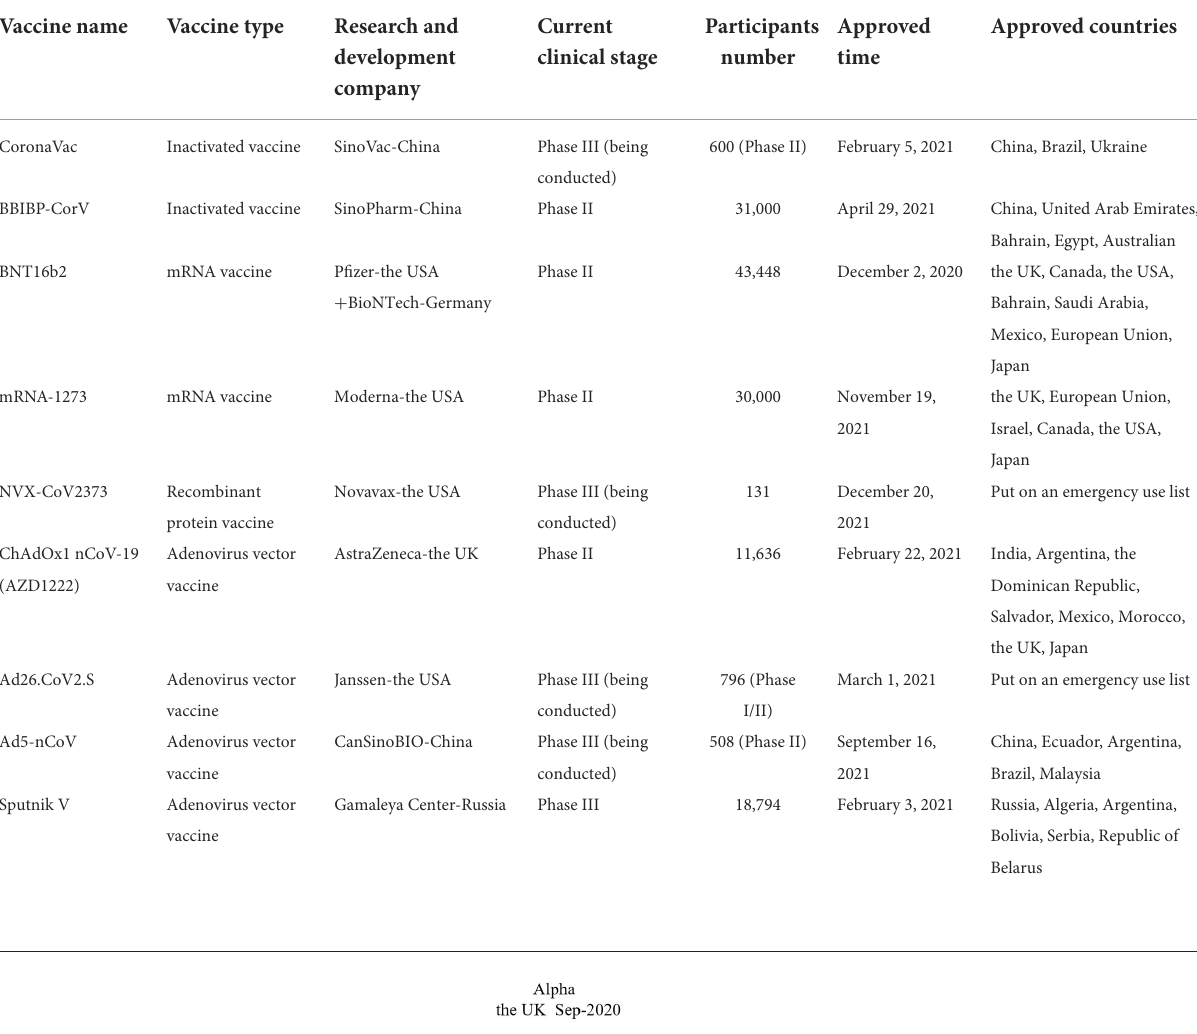
TABLE 1 Current commonly used COVID-19 vaccines.